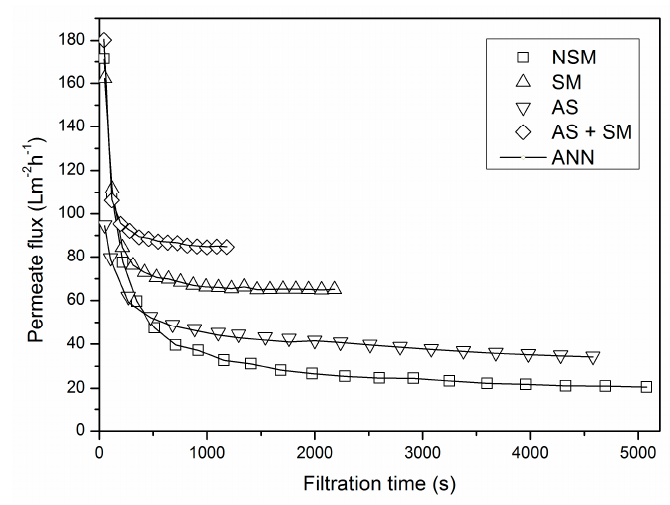
Figure 3. Prediction capability of the ANN model.